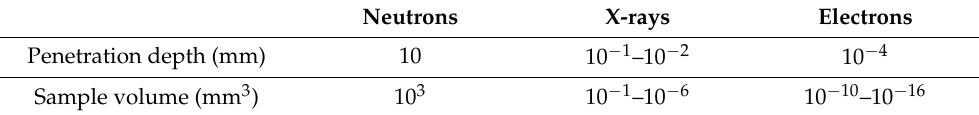
Table 1. Typical penetration depth and sample volume of neutrons, X-rays and Electrons. Neutrons X-rays